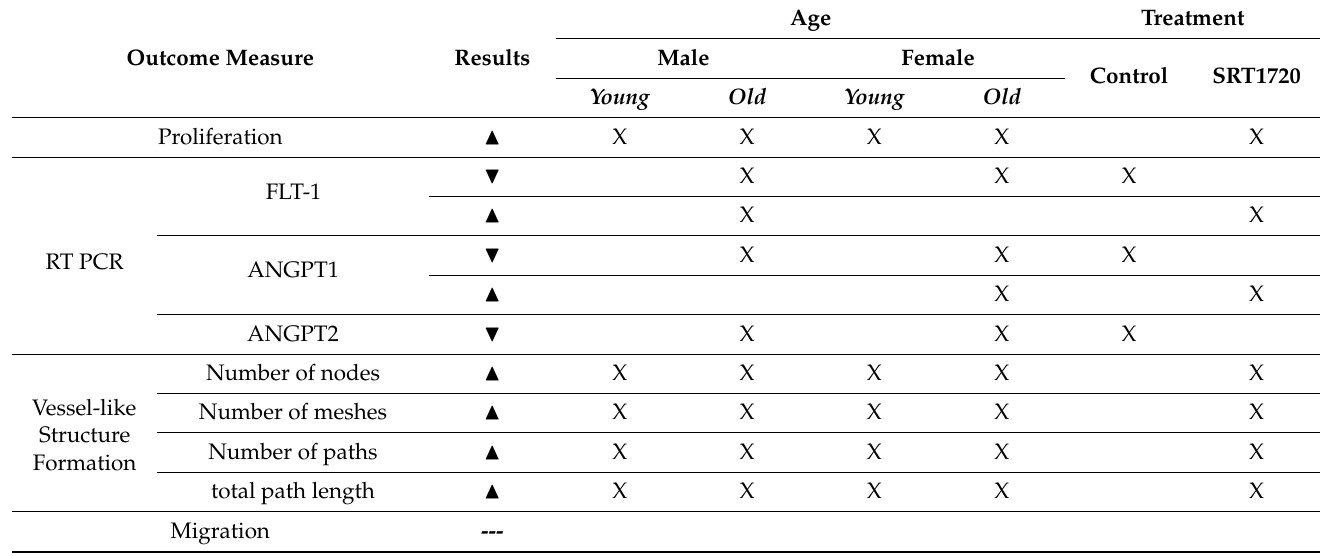
Table 1. Summary of Lung Endothelial Cell